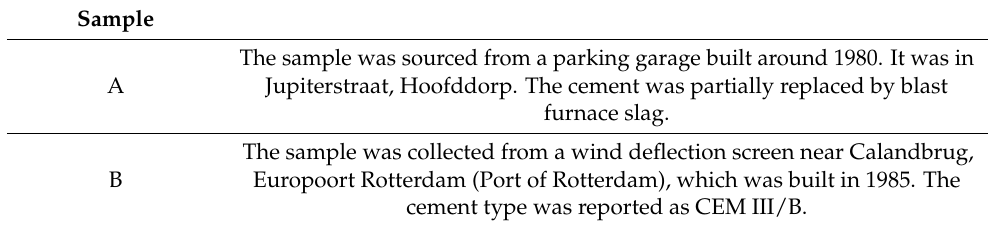
Table 1. Descriptive information of the slag concrete samples studied in the paper.